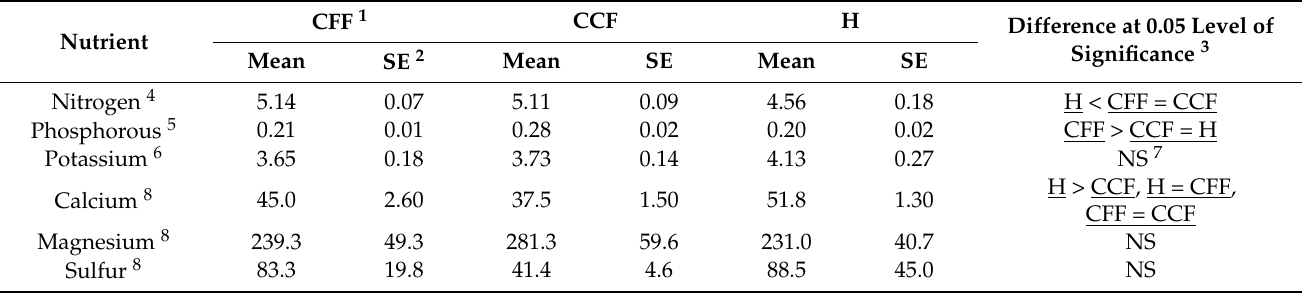
Table 4. Macronutrient concentrations in lettuce leaves.